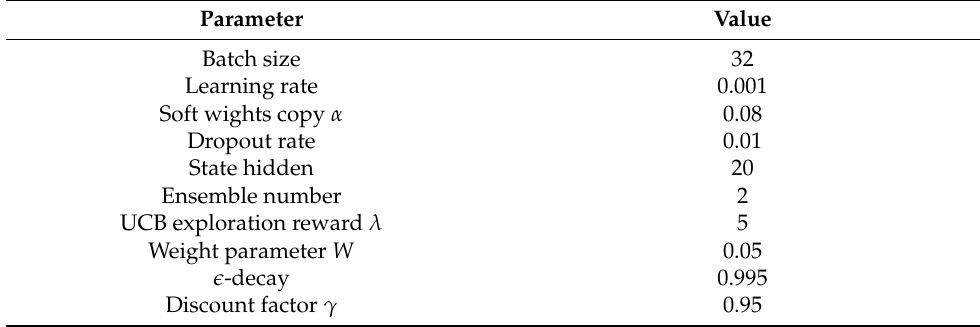
Table 2. Some relevant parameters of the